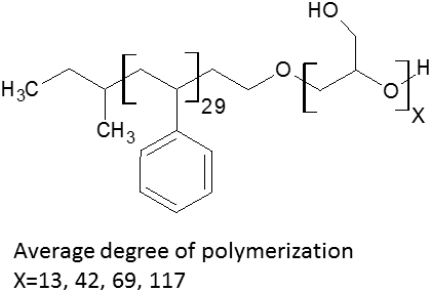
Scheme 1. Chemical structure of polystyrene- b -polyglycidol.